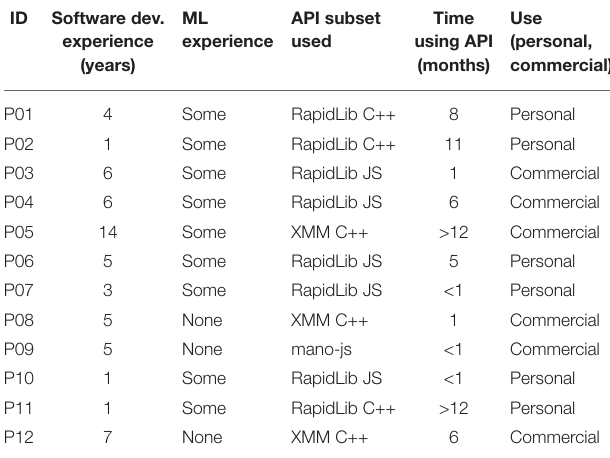
TABLE 1 | Listing of study